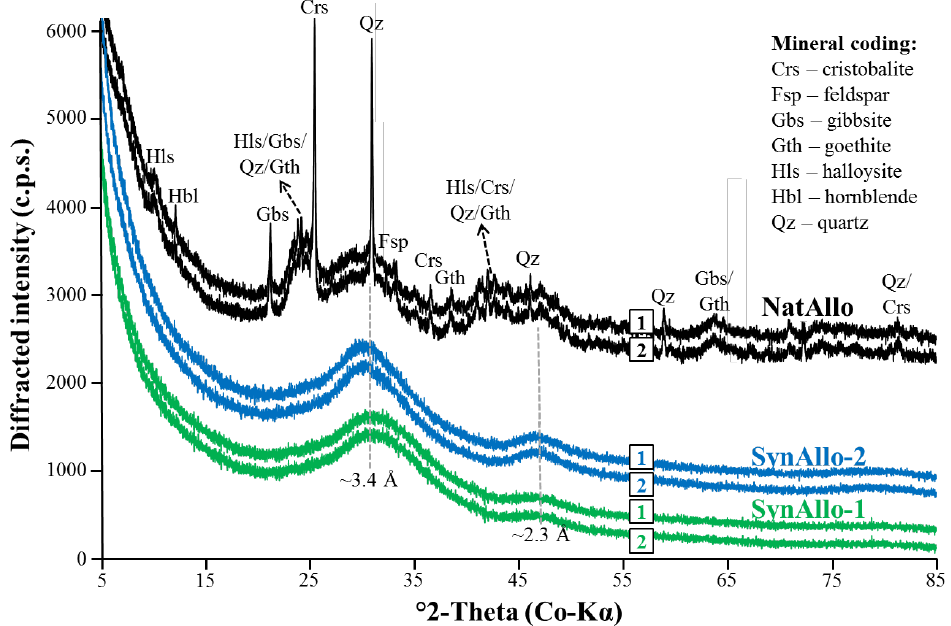
Figure 1. X-ray diffraction (XRD) patterns of Ecuadorian allophane (NatAllo) and synthetic allophanes (SynAllo-1 and SynAllo-2) used as adsorbents before the adsorption experiments (1) and with sorbed Zn 2+ ions (2). Peaks at ~3.4 Å and ~2.3 Å correspond to allophane.